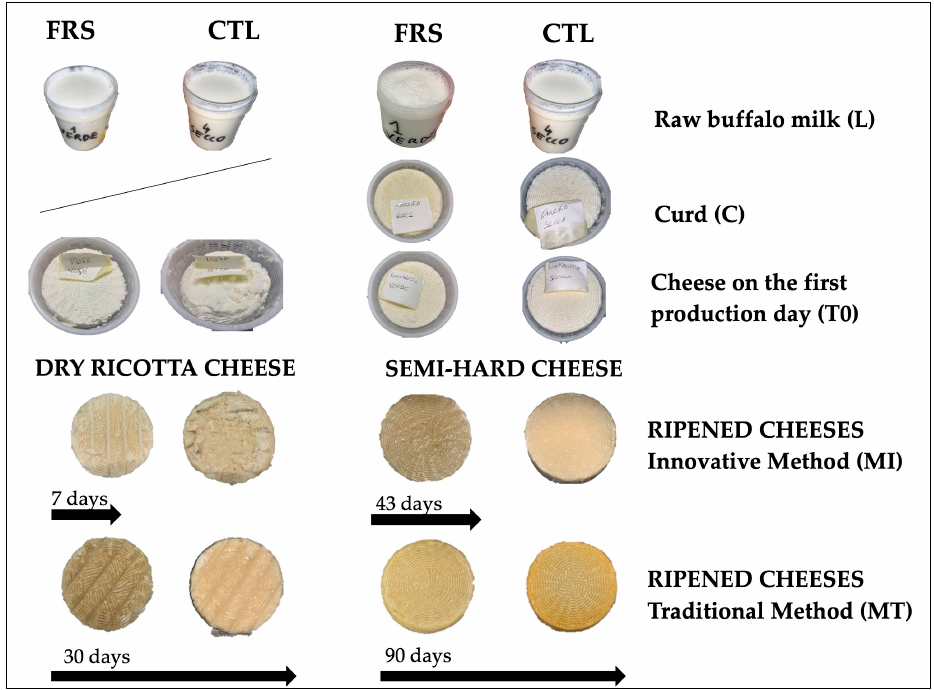
Figure 2. Experimental design schematization. FRS, production line with milk from buffaloes fed with feed rich in green fodder; CTL, production line with milk from buffaloes fed with feed without green fodder.